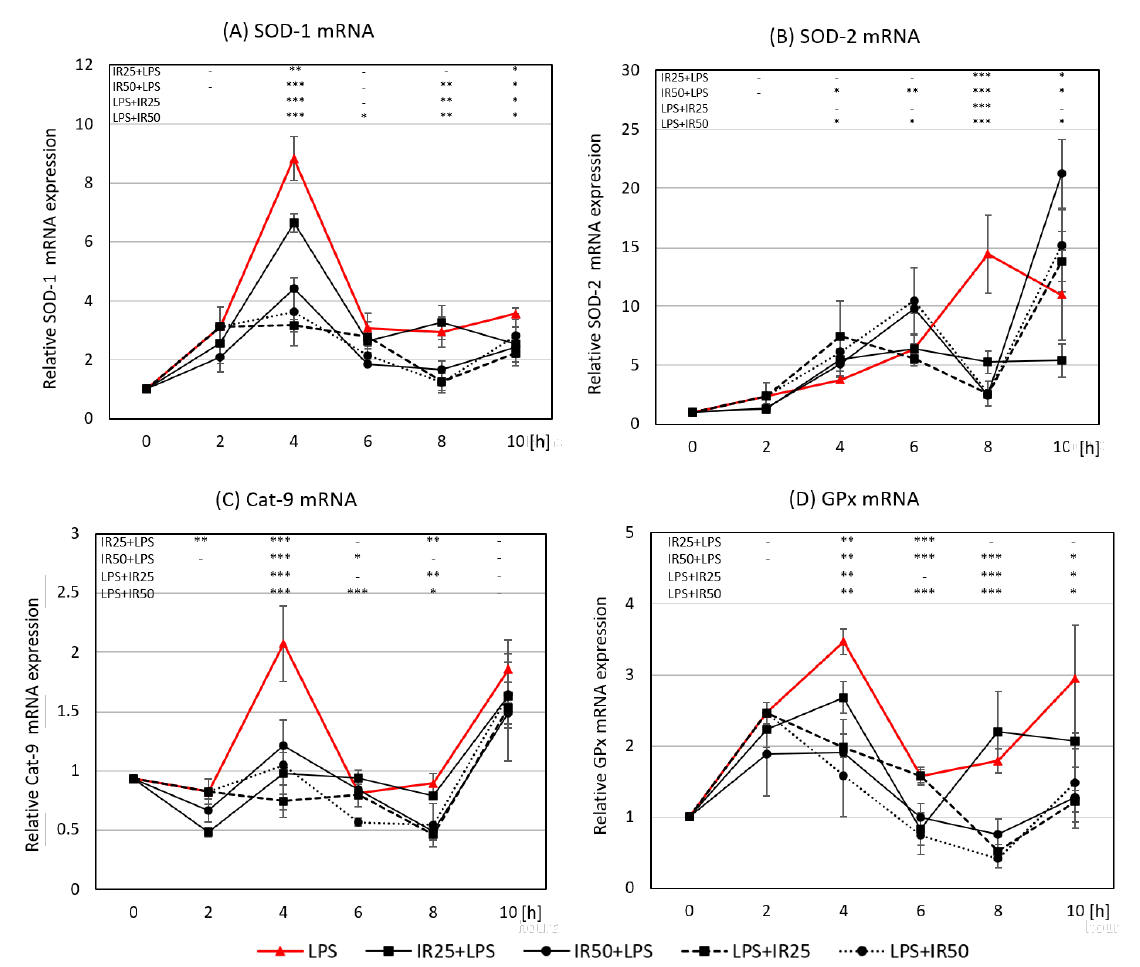
Figure 4. The time-course of the expression of crucial antioxidant enzymes in RAW 264.7 macrophages after irisin (IR; 0, 25, or 50 nM) before or after lipopolysaccharide (LPS; 100 ng/mL) treatment: ( A ) kinetics of superoxide dismutase 1 ( SOD-1 ) mRNA expression; ( B ) kinetics of SOD-2 mRNA expression; ( C ) kinetics of catalase-9 ( Cat-9 ) mRNA expression; ( D ) kinetics of glutathione peroxidase ( GPx ) mRNA expression. Irisin was administered 2 h before (IR + LPS) or after LPS stimulation (LPS + IR). Results are presented as the mean with standard deviation; n = 4–5. Statistically significant differences were calculated in relation to the IR0 + LPS group, used as a control group: * p < 0.05; ** p < 0.01; *** p < 0.001; “-“ not statistically significant.